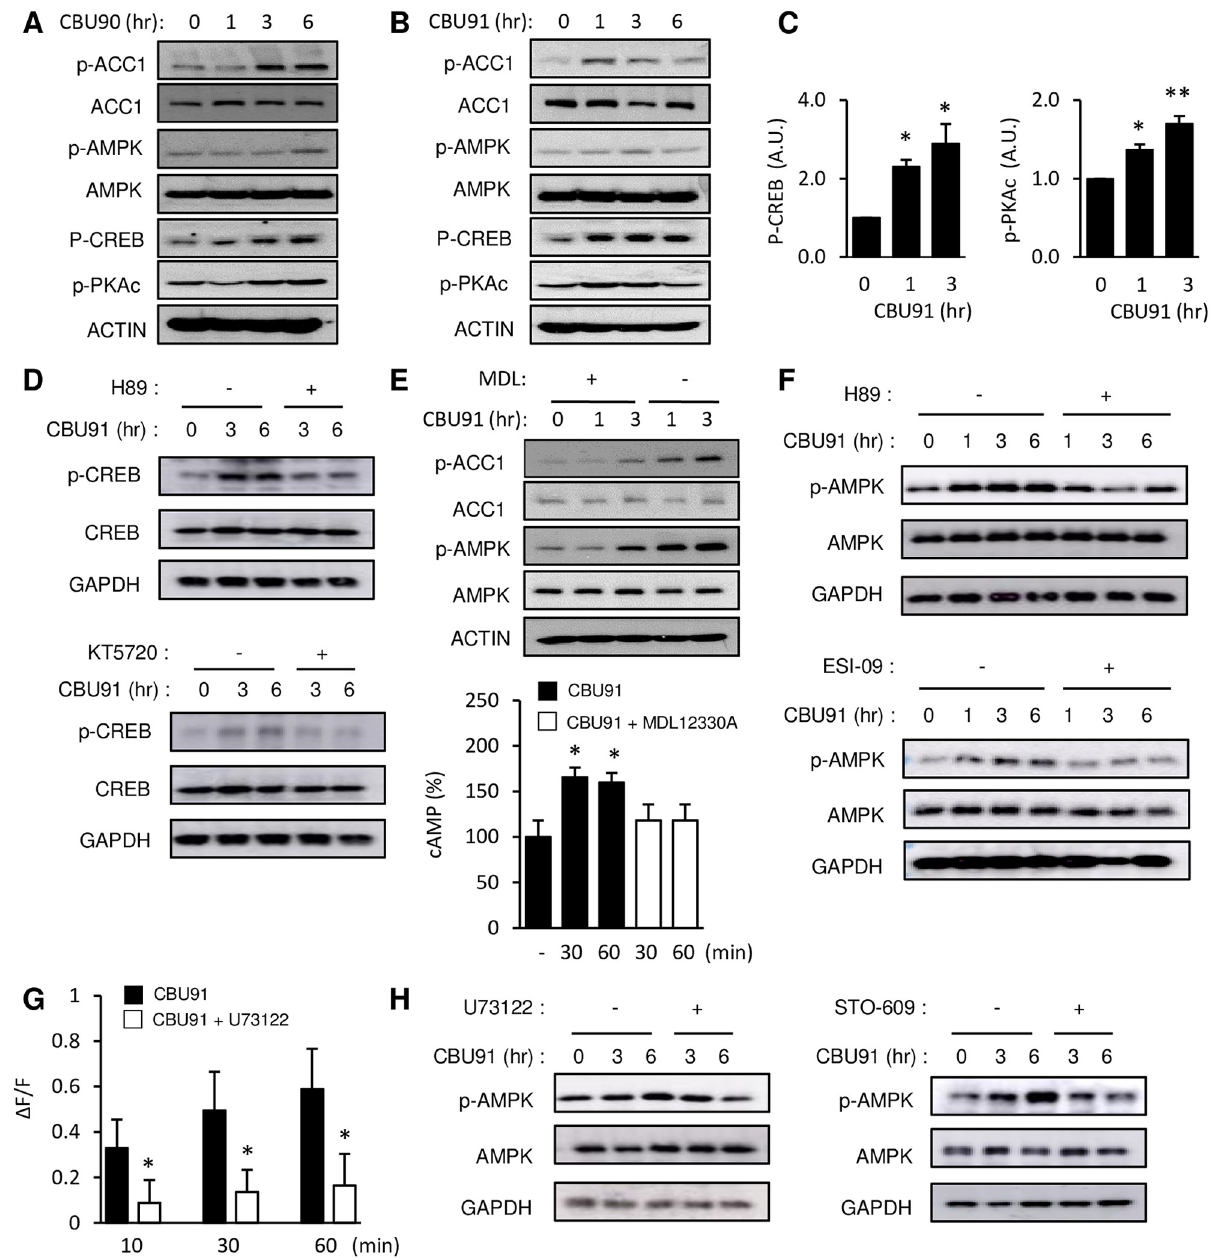
Fig 3. Compounds CBU90 and CBU91 activate AMPK via EPAC1. A, B, p-AMPK, p-ACC, p-CREB and p-PKAc in C2C12 myotubes treated with CBU90 and CBU91 in vitro are shown. C2C12 myotubes were treated with 20 μ M CBU90 or 10 μ M CBU91 for 1–6 hr. C, Quantification of PKA and CREB phosphorylation in C2C12 myotubes treated with CBU91 are shown (n = 3). D, p-CREB (S133) after treatment with CBU91(10 μ M) in the presence of the PKA inhibitors (H89, KT5720). E, (Top) p-AMPK and p-ACC after treatment with CBU91 (10 μ M) in the presence of the AC inhibitor MDL-12,330A in C2C12 myotubes. (Bottom) cAMP levels were measured in C2C12 myotubes with 10 μ M CBU91 in the presence of the AC inhibitor MDL-12,330A (n = 5). F, p-AMPK after treatment with CBU91 (10 μ M) in the presence of the PKA inhibitor (H89, 10 μ M) or EPAC inhibitor (ESI-09, 10 μ M). G, The increase in intracellular Ca2+ levels after CBU91 treatment (10 μ M) in C2C12 myotubes loaded with Ca2+ indicator Fluo-4 AM in the presence of PLC inhibitor U73122 (20 μ M). F indicates the fluorescence level and Δ F indicates the change in fluorescence (n = 5). H, p-AMPK after treatment with CBU91 (10 μ M) in the presence of PLC inhibitor (U73122, 20 μ M) or CamKK inhibitor (STO-609, 5 μ g/ml). All values are expressed as mean ± s.e.m. � , p < 0.05; �� , p < 0.005; ��� , p < 0.0005.